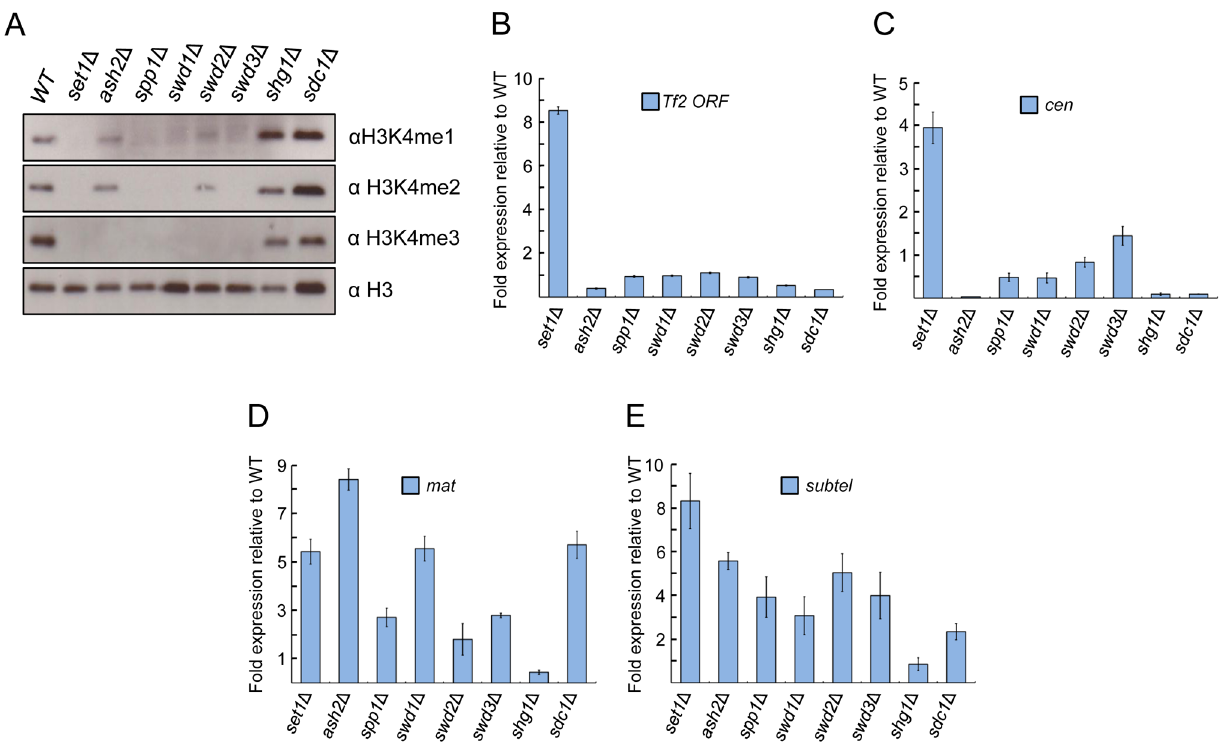
Figure 3. Set1 represses Tf2s and heterochromatic loci dependent and independent of Set1C subunits. (A) Set1C components contribute differently to H3K4me. H3K4me1, H3K4me2, and H3K4me3 were analyzed from histone extracts of indicated Set1C mutant strains by western blotting. (B) Set1-mediated repression of Tf2s is little affected in other Set1C mutant strains. (C–E) Set1 represses heterochromatic loci dependent and independent of Set1C. qRT-PCR was performed as in Figure 1 (s.d., error bars; n=3). Pericentromeric repeat dg ( cen ), silent mating type cenH ( mat ), subtelomeric prl70 ( subtel ).